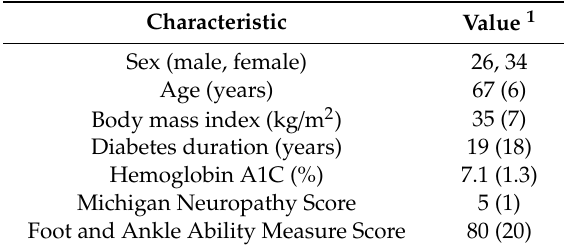
Table 1. Participant